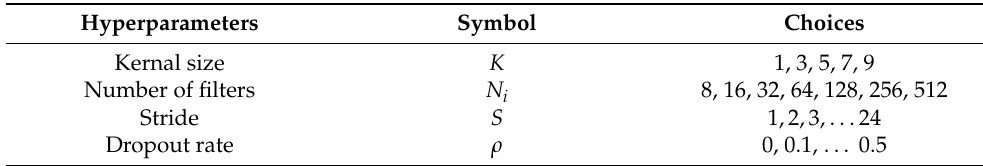
Table 2. Search space of stride-TCN used by Bayesian optimization.